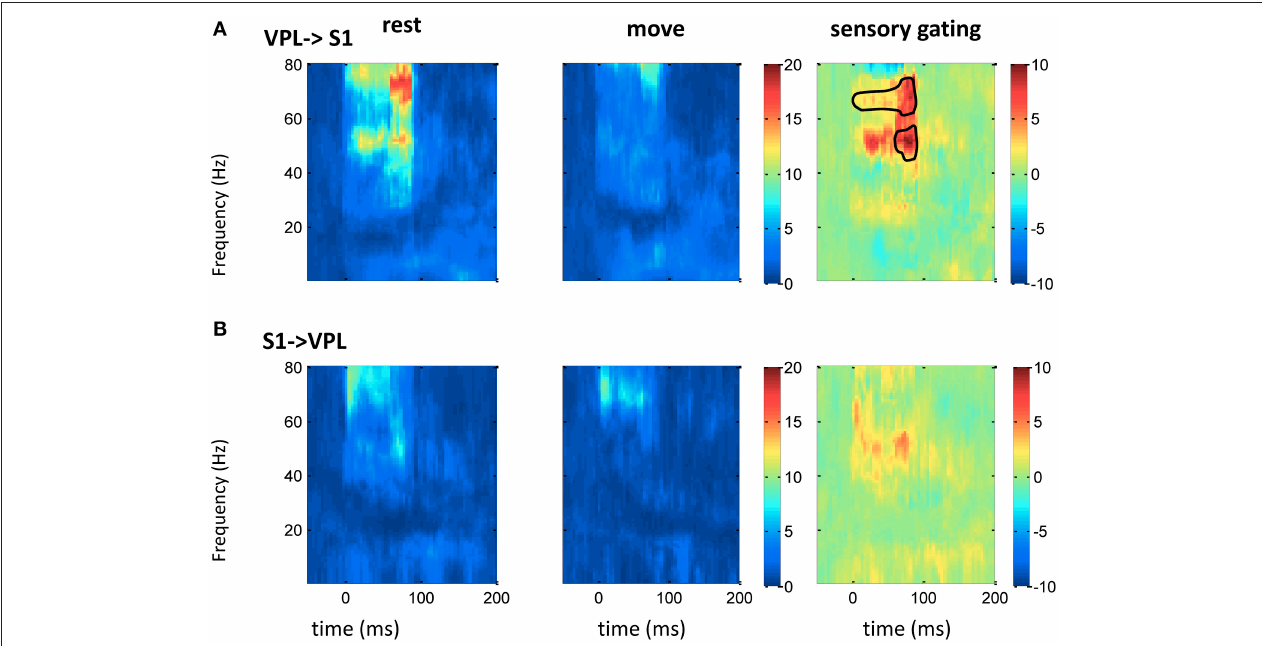
FIGURE 5 | GC between VPL and S1 in frequency domain. After normalizing the GC at each frequency to its baseline (100ms before tactile onset), the time-frequency GC map shows strong directional coupling from VPL to S1 (A) than that from S1 to VPL (B) during rest (left) and movement condition (middle). The movement induced sensory gating (right), which is the difference of rest and move, is dominantly at gamma frequency band and is stronger and faster from VPL to S1 than that from S1 to VPL. Each heat-map is the mean time-frequency representation across sessions ( n = 10 ). Area within circle represents elements significantly different from zero ( p < 0.05 for signrank test, n = 10